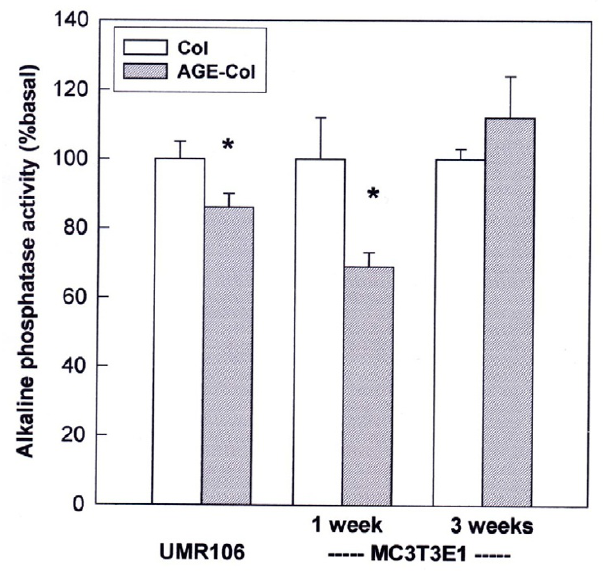
Figure 5 Effect of an AGE-modified type I collagen matrix on the ALP activity of UMR106 and MC3T3E1 cells. Osteoblastic cells were cultured on control or AGE-modified type I collagen at 37 ° C either for 24 hours (UMR106 cells), or for one and three weeks (MC3T3E1 cells). At the end of all incubations, the cell monolayer was lysated in 0.1 % Triton X-100. Alka- line phosphatase activity was determined in the lysates using p-nitro-phenyl-phosphate as a substrate, and was normalized for cellular protein content. Results are given as a percentage of the corresponding basal condition (unmodified collagen), and are expressed as the mean ± SEM. Differences between collagen vs. AGE-collagen are as follows: * p<0.01. Basal ALP activity was 168 ± 8 nmol pNP / min x mg protein for UMR106 cells; 2.77 ± 0.33 nmol pNP / min x mg protein for a one-week culture of MC3T3E1 cells; and 3.05 ± 0.23 nmol pNP / min x mg protein for a three-week culture of MC3T3E1